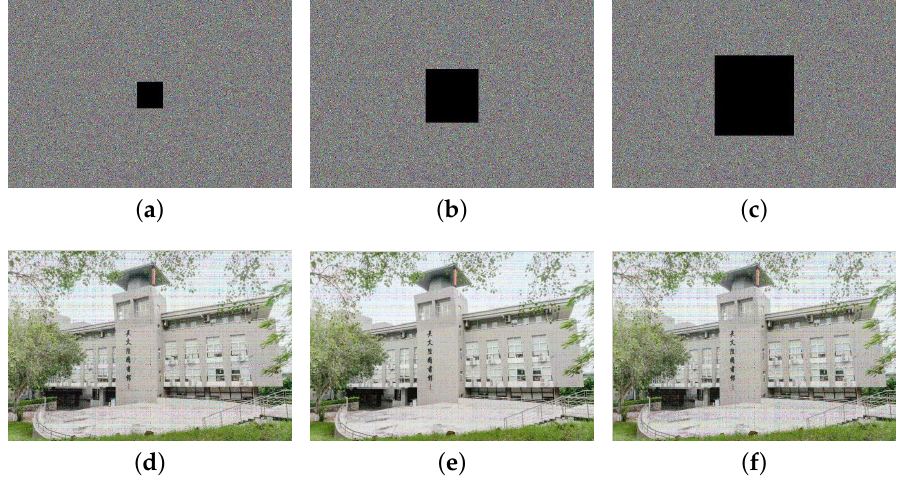
Figure 13. The ciphertext and decryption image after adding occlusion noise: ( a ) 96 × 96 occlusion noise ciphertext images; ( b ) 200 × 200 occlusion noise ciphertext images; ( c ) 300 × 300 occlusion noise ciphertext images; ( d ) 96 × 96 occlusion noise decryption images; ( e ) 200 × 200 occlusion noise decryption image; ( f ) 300 × 300 occlusion noise ciphertext images.